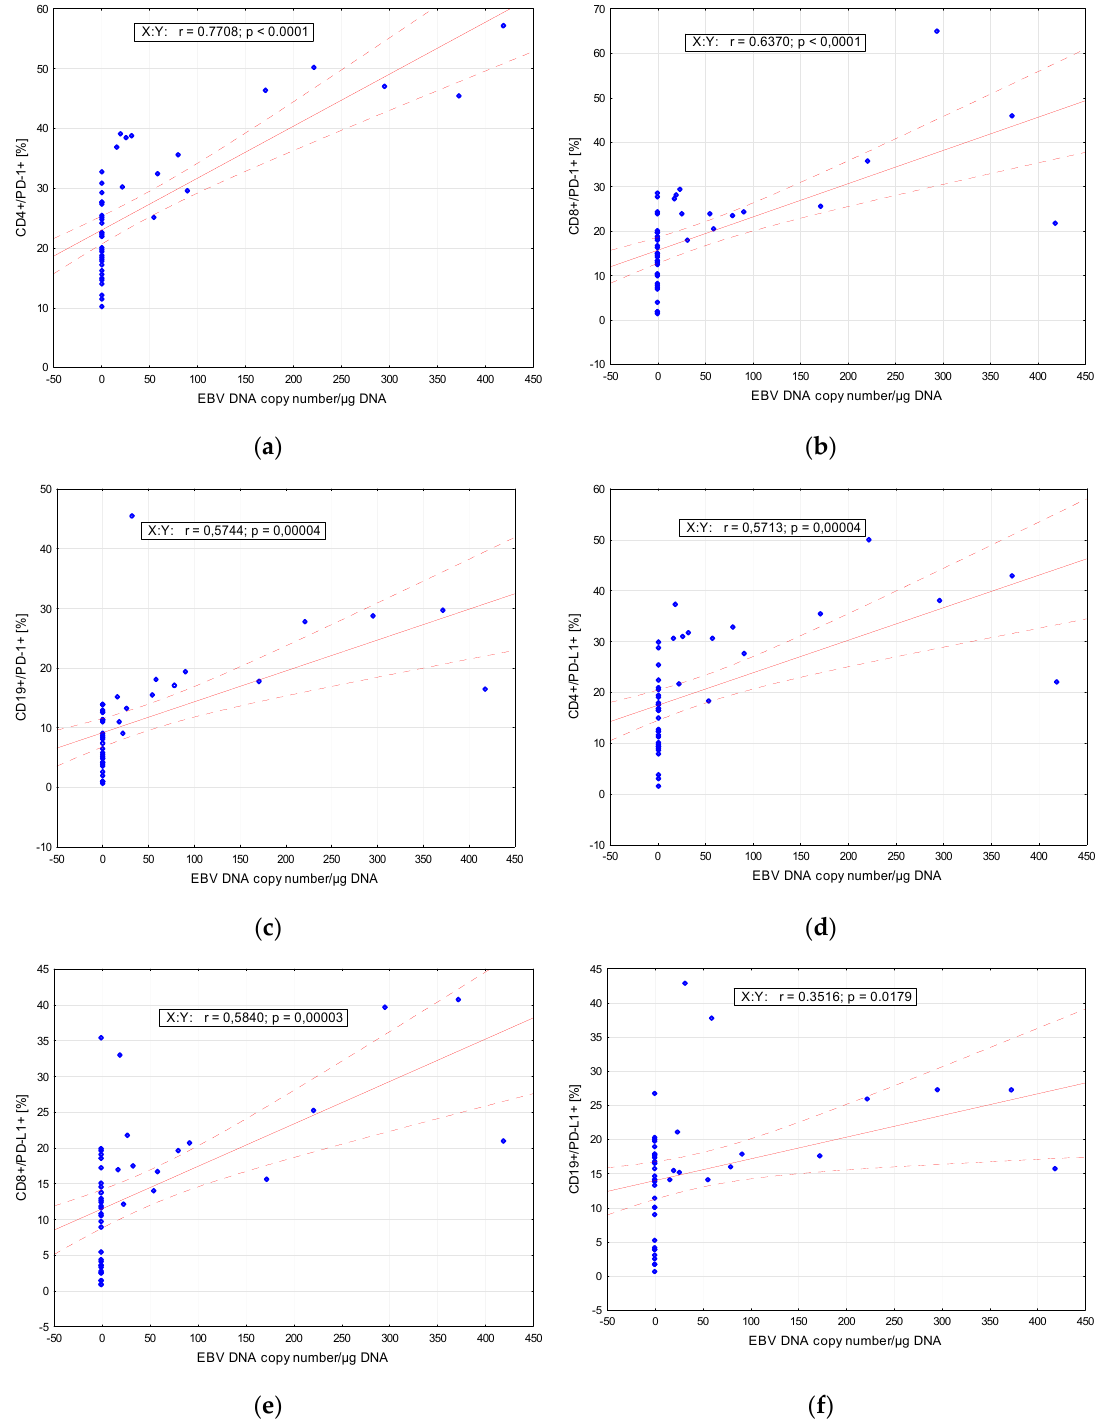
Figure 1. Correlation of PD-1 and PD-L1 – positive cells and Epstein-Barr virus (EBV) DNA copy